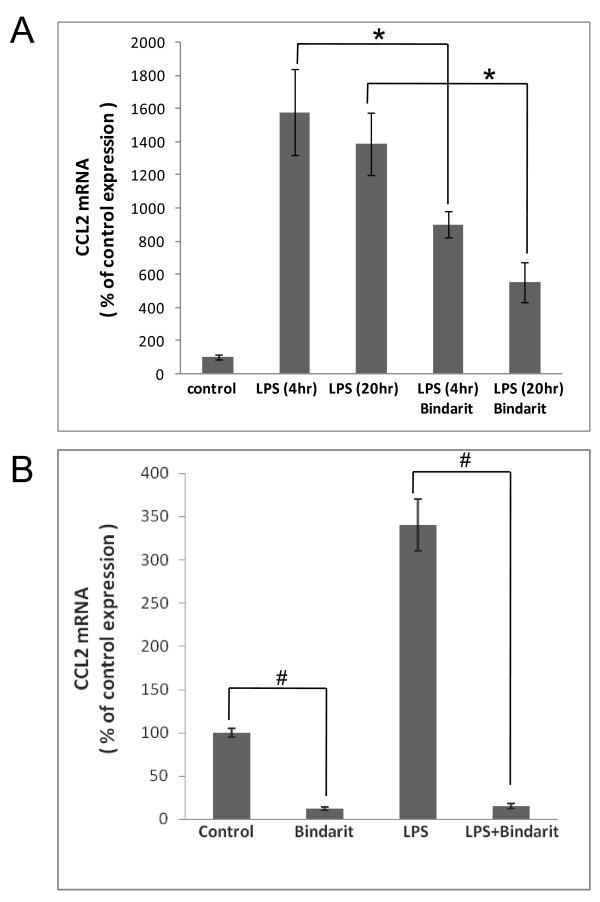
Bindarit effects on LPS-stimulated CCL2 mRNA in cultured astrocytes and microglia. Separate cultures of astrocytes (A) and microglia (B), prepared from C57BL/6 mouse brain, were pre-treated with 300 μM bindarit for 1 hr, then incubated with ± 100 ng/ml lipopolysaccharide (LPS) in the continued presence of bindarit. Astrocytes cultures were exposed to LPS for the indicated times to stimulate CCL2 expression. Microglial cultures were only exposed to LPS for 4 hr, as these highly express CCL2 even under basal conditions. Control cultures received only vehicle. Relative CCL2 RNA levels were determined by qRT-PCR, and effects of bindarit treatment reported as % change compared to control cultures. Brackets designate comparison between the two respective groups. *P < 0.05; #P < 0.01.